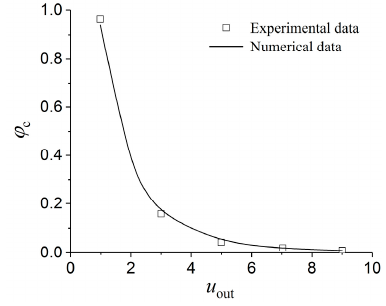
Figure 6. Impacts of outlet air velocity u out on φ c.